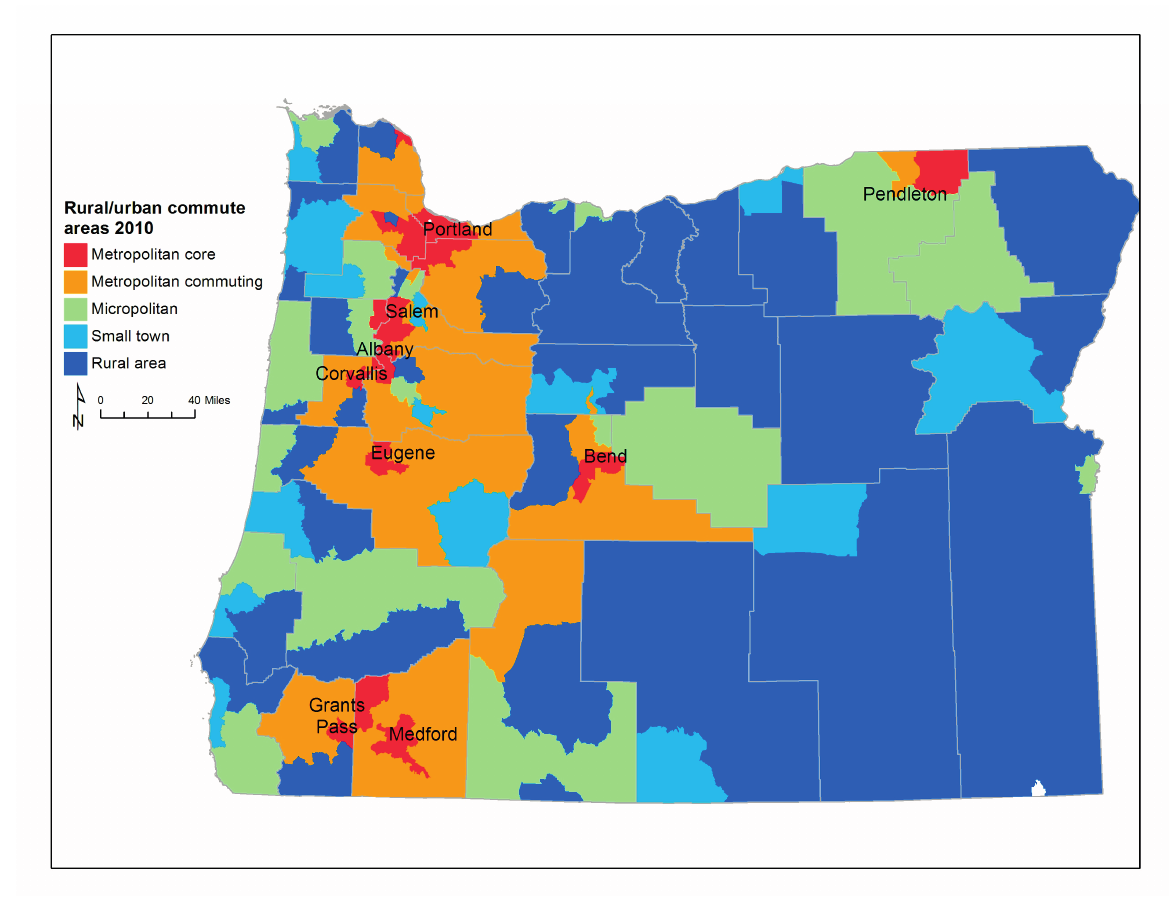
Figure 1. Rural-urban commuting areas in